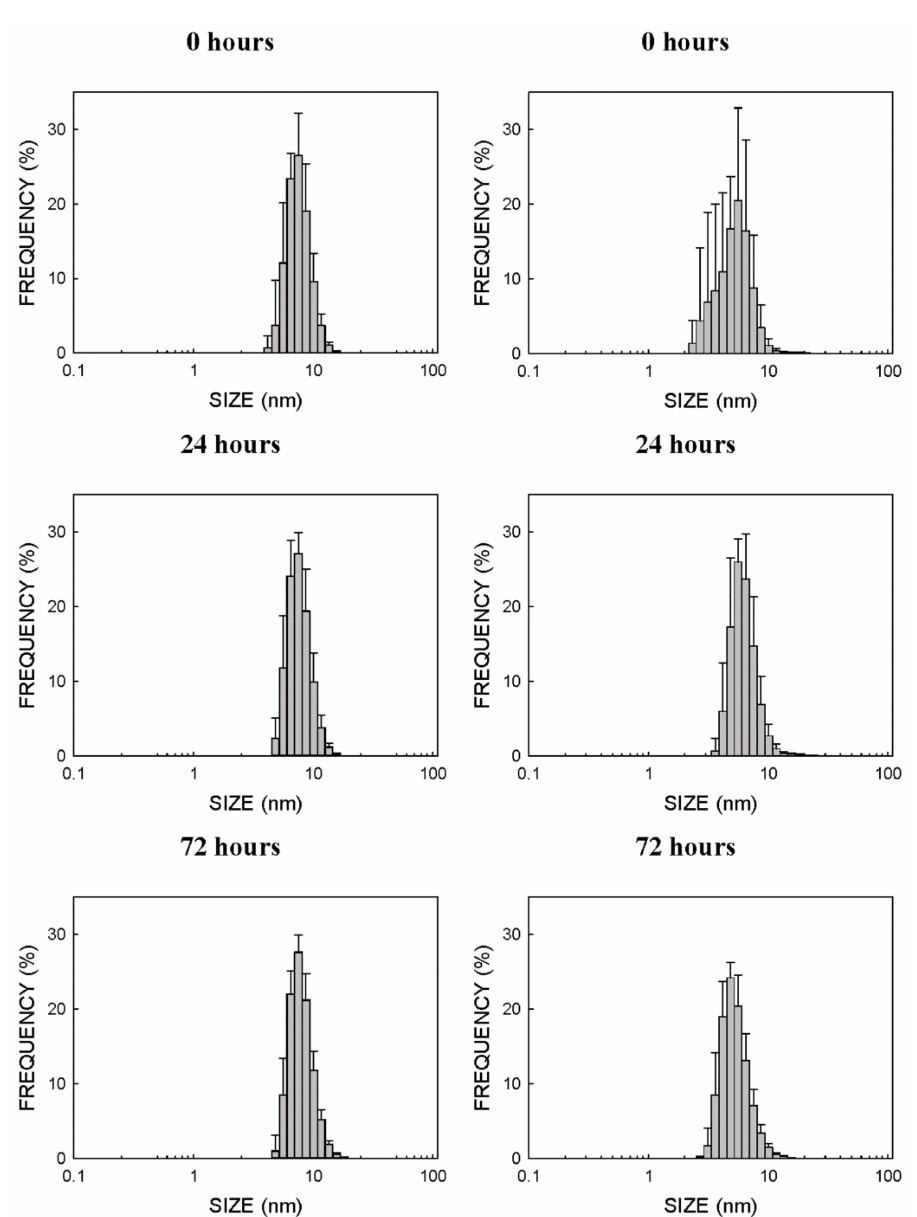
Figure 2. Analysis of the size and distribution of CdSe-QDs in water (( left ) panels) and cell culture medium (( right ) panels). Size was determined by DLS. The cell culture medium was the RPMI cellular medium supplemented with 10% FBS. DLS was analyzed in quintuplicate with a minimum of 10 runs per measurement. Determinations were performed by Nanoimmunotech SL (https: //nanoimmunotech.eu/en accessed on 1 February